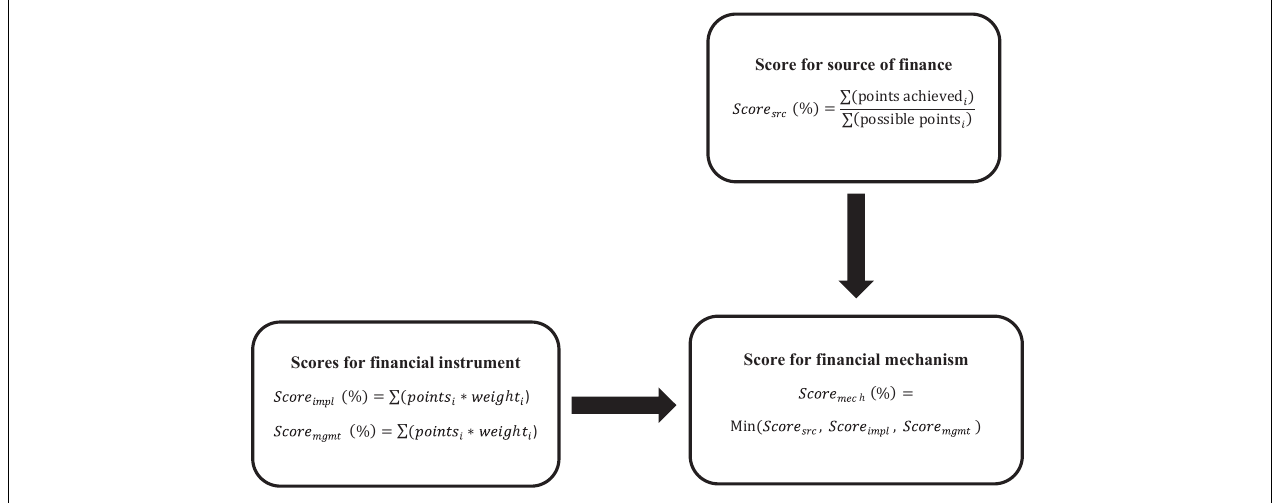
FIGURE 2 | Visual description of calculation methodologies and matrix approach for scoring financial mechanisms (mech) based on indicators (i) for individual sources of finance (src), and implementation (impl) and management (mgmt) of individual financial instruments.